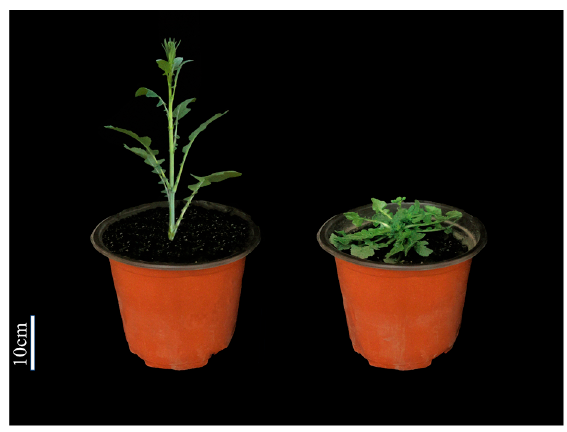
Figure 1. Phenotypic characterization of Brcd1 YS and YS. The dwarf mutant ‘ Brcd1 YS ’ ( right ) and wild-type ‘YS’ (Yellow Sarson, left ) grown under natural conditions. Scale bars = 10 cm.